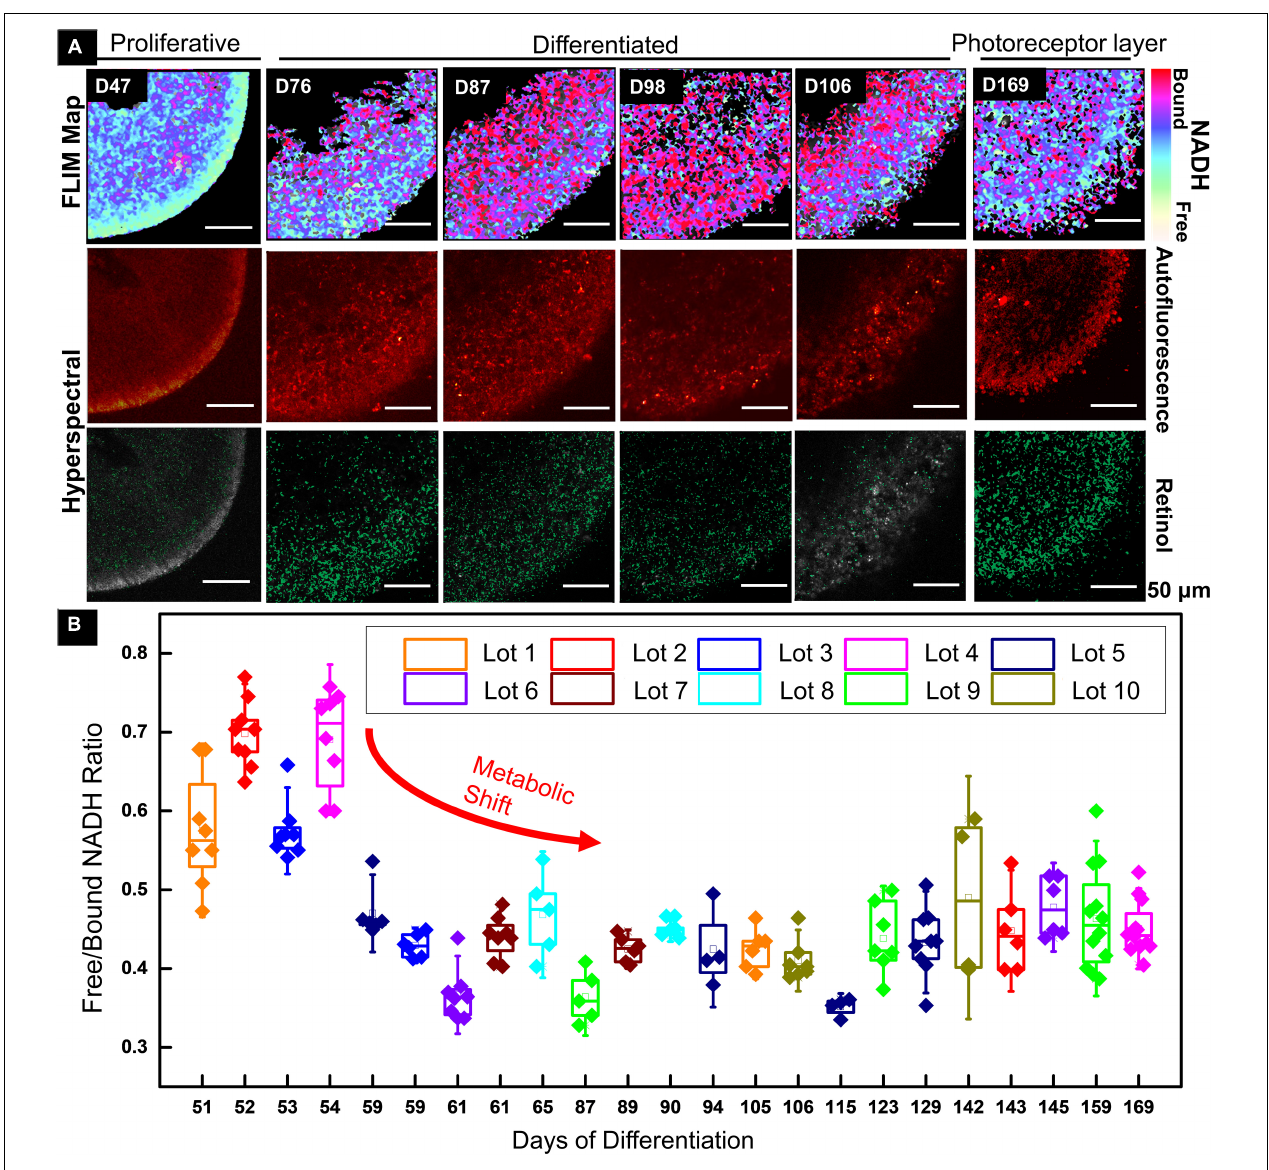
FIGURE 1 | Functional imaging results of CSC-14 hESCs derived RtOgs. (A) FLIM and HSpec images of a typical RtOg. RtOg ages were from D47 to D169 of differentiation. The first row shows the pseudo-color-coded images that indicated free/bound (f/b) NADH ratio distribution. The second row shows the total autofluorescence emission from all intrinsic fluorophores that were excited by a 740 nm laser in HSpec scanning mode. The third row shows the retinol distribution in the imaged cross section and the results were calculated with spectral phasor plots from HSpec images. (B) f/b NADH ratio boxplot that summarized RtOgs from D51 to D169 of differentiation. The data set included 10 GMP-compatible batches of RtOgs. The boxplot indicates the 25th percentile, median and 75th percentile of the datapoints and the error bar indicates 1.5 × standard